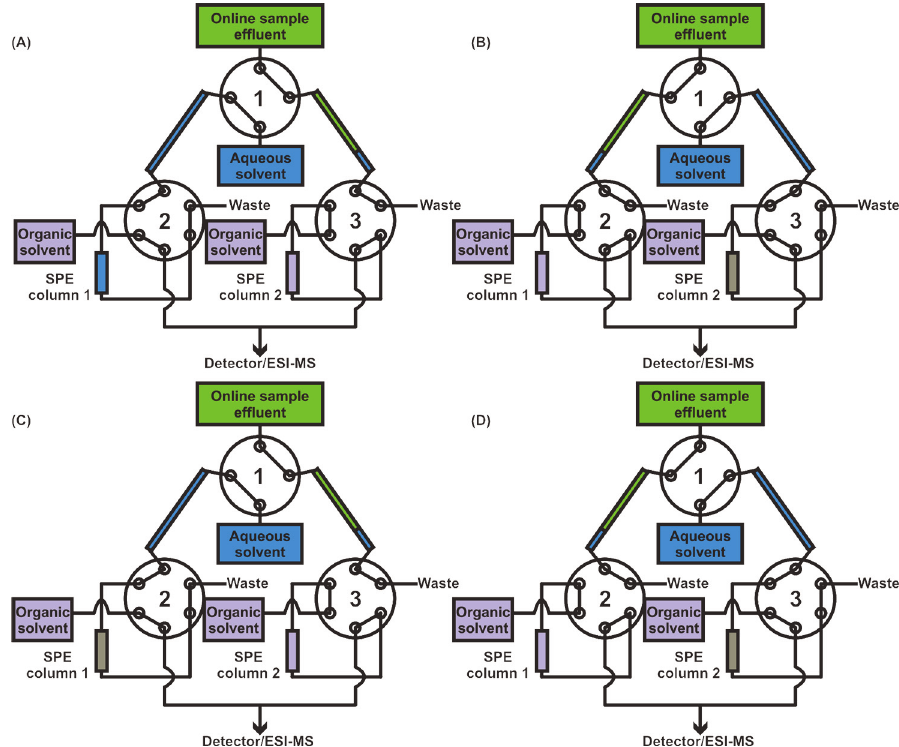
Fig 3. Solid phase extraction desalter. Setup starting from initial sample effluent flow incorporates two sample loops, three valves, and two C18 columns. During (A), sample effluent fills sample loop 2 for 9 minutes, while the aqueous solvent flows through sample loop 1, over column 1, and to waste. The organic solvent flows over column 2 and to the mass spectrometer. (B) Upon switching of the valves, the sample effluent fills sample loop 1 for 9 minutes. Aqueous solvent forces the 1.5 μ L head of aqueous solvent, the 4.5 μ L of sample effluent, and an additional 2.1 μ L of aqueous solvent over column 2 to equilibrate the column, load the sample, and rinse away the salts. Organic solvent runs through column 1 and to the detector. (C) The next valve switch again exchanges the sample loop filled by effluent, while column 1 is equilibrated, loaded, and rinsed. The analytes captured on column 2 are eluted by the organic solvent and sent to the detector. (D) When the valves switch again, the sample effluent fills the opposite loop, column 2 is equilibrated, loaded, and rinsed, and column 1 is eluted with organic solvents and those analytes are sent to the detector. The pattern repeats until the experiment is completed, with each cycle requiring 9